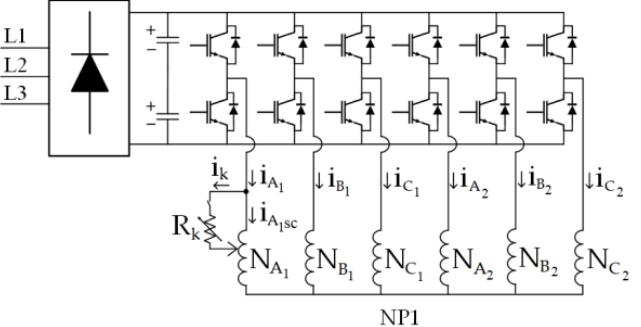
Figure 5. Demonstration of the ITSC fault related to 1NP on the six-phase inverter-fed and ASPIM stator windings.